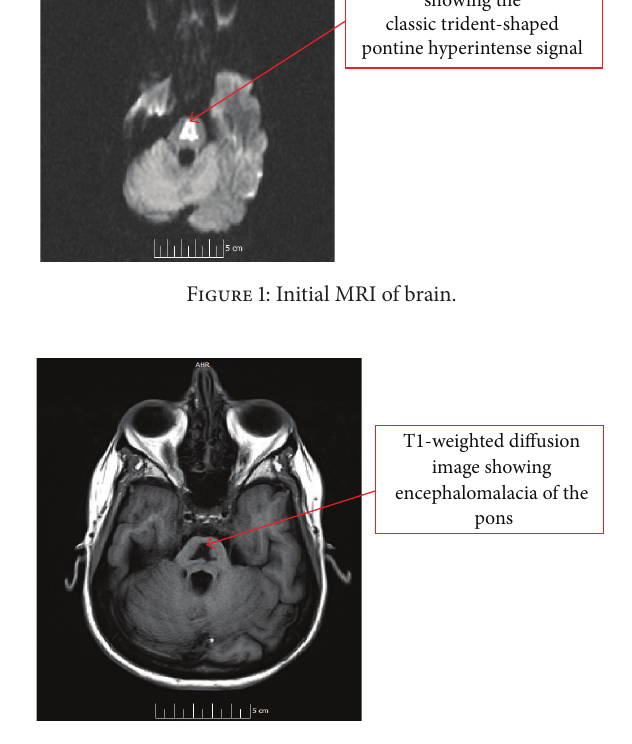
Figure 2: Repeat MRI of brain after